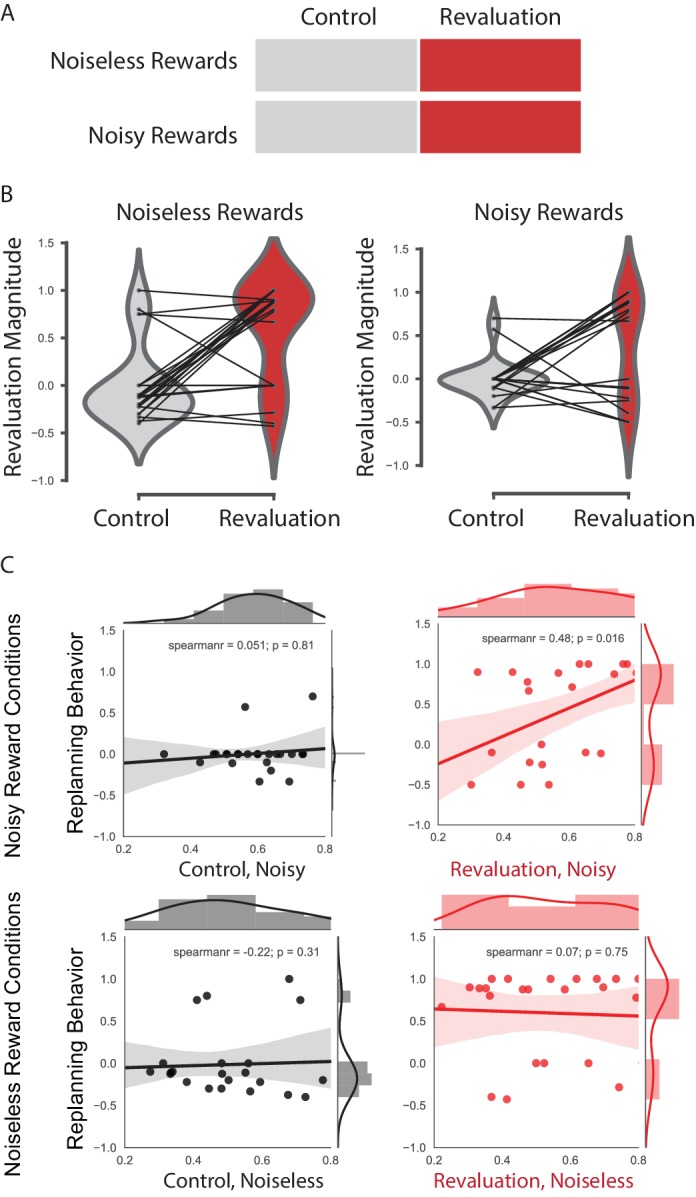
(A) Illustration of experimental conditions obtained by crossing revaluation and noise.(B) Behavioral revaluation scores in the control and revaluation conditions, assessed separately in the noisy rewards vs. noiseless rewards conditions. Half of the trials in the control and revaluation conditions had fixed rewards (noiseless rewards condition) and half had noisy rewards (noisy rewards condition). We used an ANOVA to compare replanning behavior, evidenced by the revaluation magnitude, in the conditions with no variance in the rewards (noiseless condition) vs. conditions with noisy reward (noisy condition). Analysis of variance revealed a significant effect of the revaluation condition on behavior (F(1, 23) = 29.57, p < 0.0001) but no significant effect of the noise condition (F(1, 23) = 0.91, p = 0.34), and no significant interactions (F(1, 23) = 1.35, p = 0.25. Within each of the noise conditions (noiseless, noisy), participants significantly changed their choice from the Learning phase to the Test phase in the revaluation condition, but not the control condition: noiseless rewards condition: t(23) = 4.6, p = 0.00003; noisy rewards condition: t(23) = 3.06, p = 0.003. (C) Offline replay of distant past states predicts replanning. Breakdown of correlation between MVPA evidence for replay and subsequent replanning behavior, computed separately for the noisy and noiseless rewards conditions. All correlations were conducted using the last 10 TRs (out of 15 TRs) of each rest period, excluding the first 5 TRs to reduce residual effects of Stage II stimulus-presentation prior to rest. This breakdown revealed that MVPA evidence for Stage I replay was significantly correlated with subsequent replanning behavior in revaluation blocks in the noisy rewards condition (Spearman’s rho = 0.48, p = 0.016), but not the noiseless rewards condition (Spearman’s rho = 0.07, p = 0.75). We then ran bootstrap analyses to assess the differences in correlations between conditions. The difference in correlations between revaluation and control was trending but not significant in the noisy rewards condition (p = 0.066) and it was not significant in the noiseless condition (p = 0.16). There was no overall interaction between revaluation/control and noisy/noiseless; i.e., the revaluation vs. control difference was not significantly larger in the noisy condition than the noiseless condition (p = 0.34).